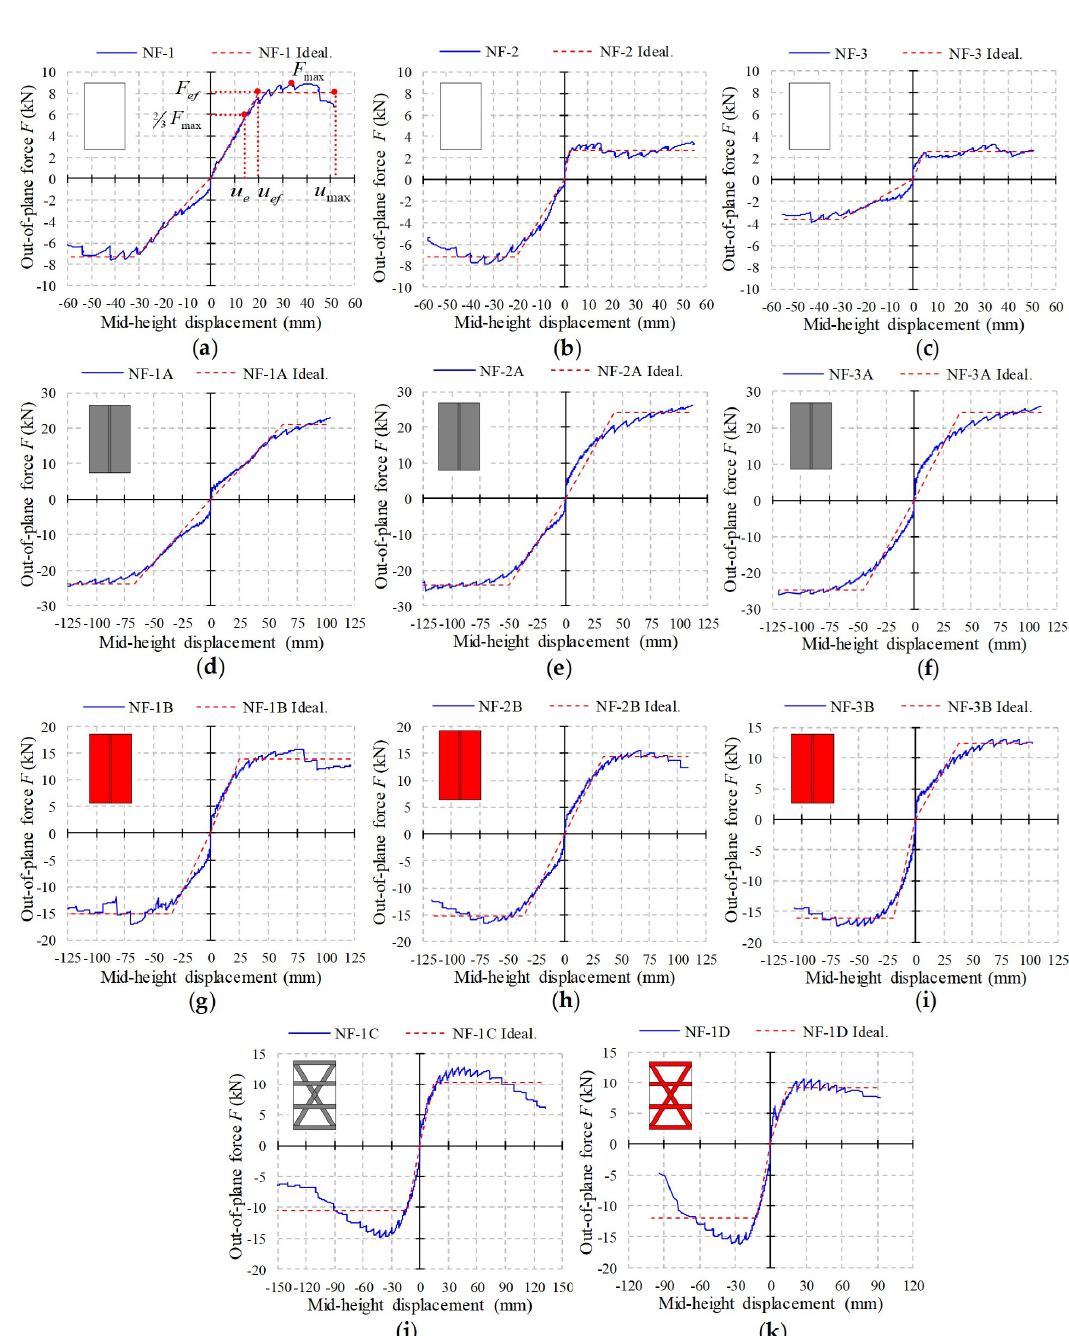
Figure 14. Bilinear idealization of specimens’ hysteresis envelopes: ( a ) NF-1, ( b ) NF-2, ( c ) NF-3, ( d ) NF-1A, ( e ) NF-2A, ( f ) NF-3A, ( g ) NF-1B, ( h ) NF-2B, ( i ) NF-3B, ( j ) NF-C, and ( k )